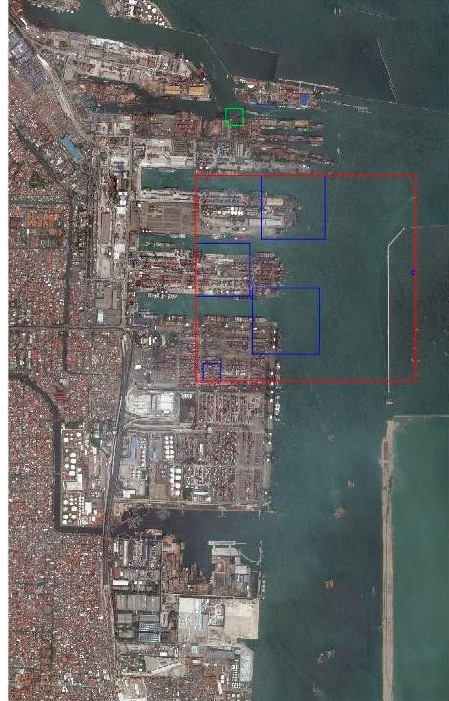
Figure 11. Detection on Jakarta Port in Indonesia by SIFT-